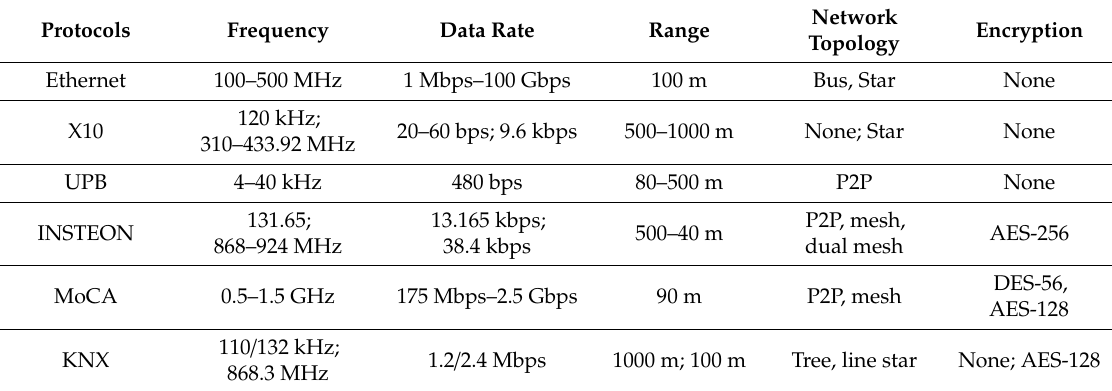
Table 1. Wired communication protocols.